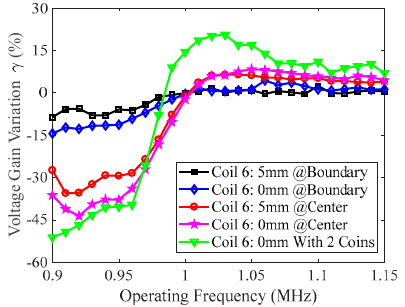
Figure 19. Measurements of γ varying with operating frequency under different positions for Coil 6.